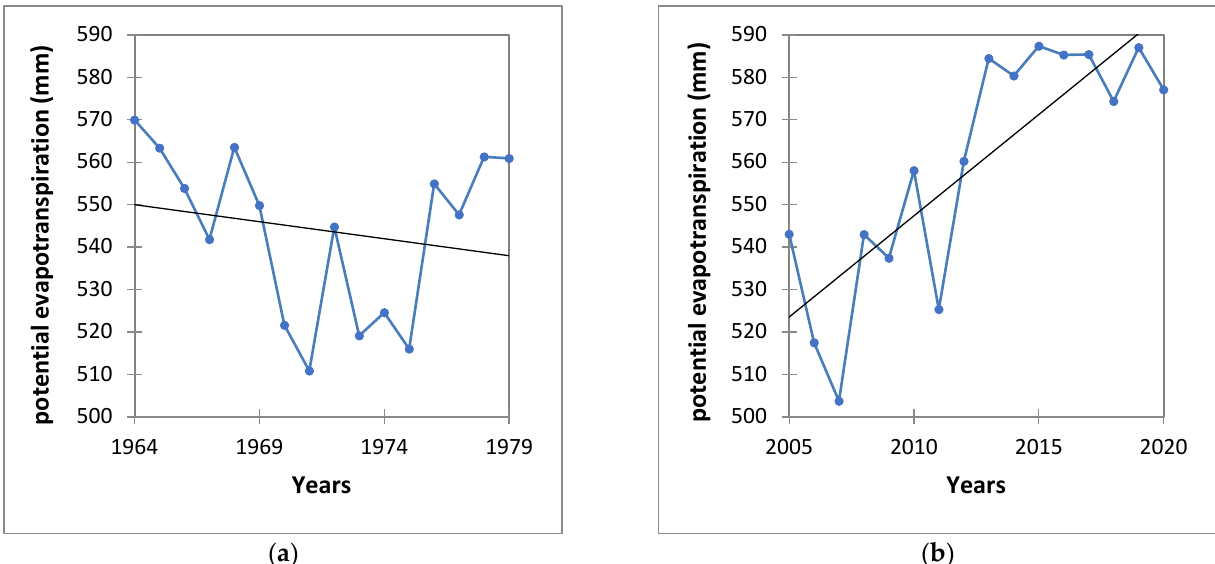
Figure 9. Potential evapotranspiration and trend line in black colour: ( a ) 1964 – 1979; ( b ) 2005 – 2020 . The period from 2005 to 2020 shows an average value of 6.730 m 3 /s. As can be seen in Figure 10, there is a non-significant decreasing trend in the current streamflow. The magnitude of Sen’s slope is − 0.082 m 3 /year, which indicates a decreasing trend (Table